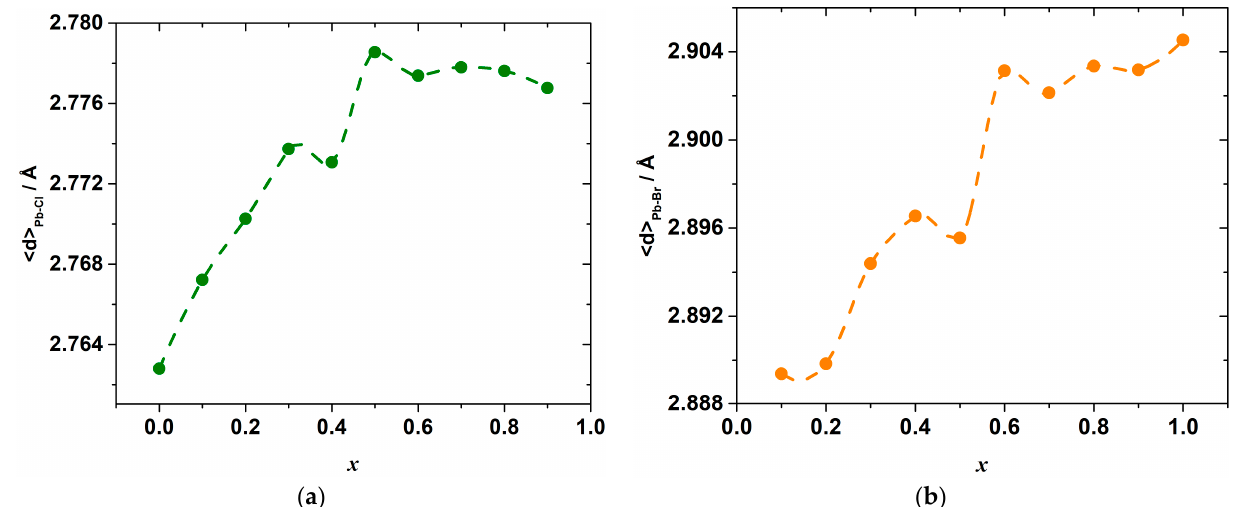
Figure 6. Average bond lengths Pb–Cl ( a ) and Pb–Br ( b ) as a function of composition x in CH 3 NH 3 Pb(Cl 1 − x Br x ) 3 as simulated by molecular dynamics.